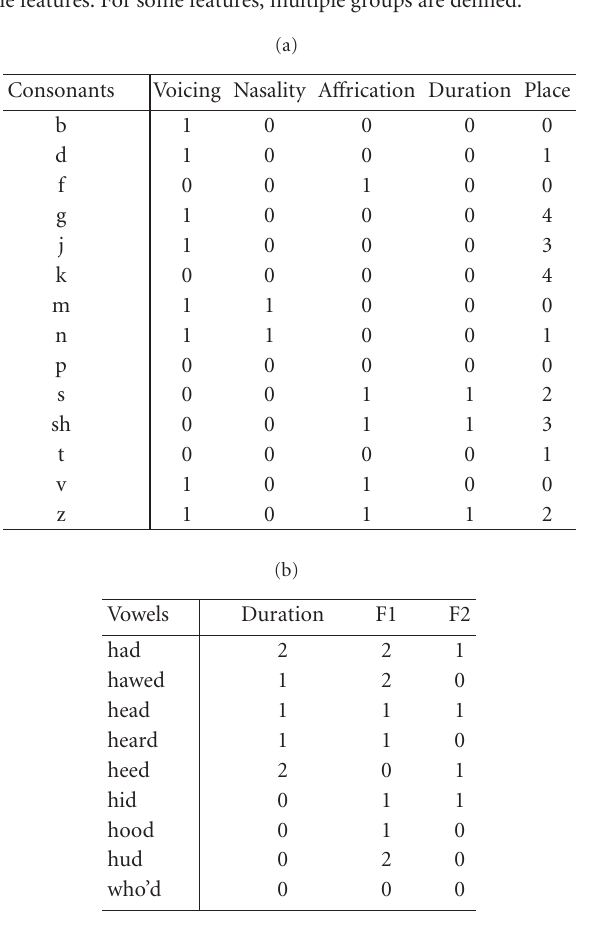
Table 2: Information transmission analysis classification matrices for (a) consonants and (b) vowels. The numbers in each column indicate which tokens are grouped together for analysis of each of the features. For some features, multiple groups are